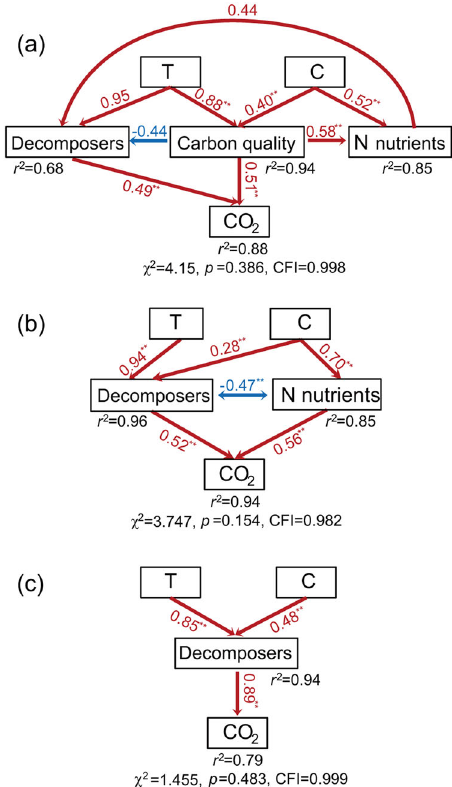
Fig. 7 Structural equation modeling to describe the effects of factors on the CO 2 emission rate of three layers soil. a surface, b interlayer, c deep soil. Arrows indicate the hypothesized direction of causation. Red indicates a positive relationship; blue indicates a negative one. Arrows are labeled with standardized path coef fi cients (* p < 0.05, ** p < 0.01), and the proportion of variance explained ( r 2 ) is indicated below the variables. At the bottom of the models are goodness-of- fi t statistics. N nutrients nitrogen nutrients, T temperature, C incubation